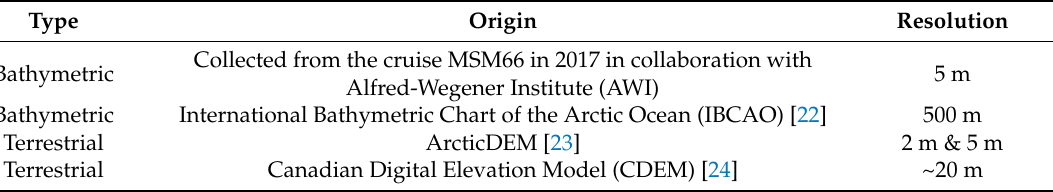
Table 1. Utilized elevation